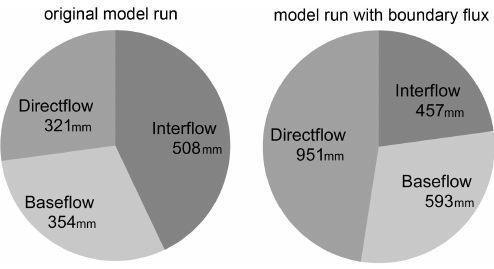
Fig. 18. Components of modeled runoff. Subbasin K¨onigsseetal – annual sums [mm] 2007. Results for original model run and model run with implemented boundary